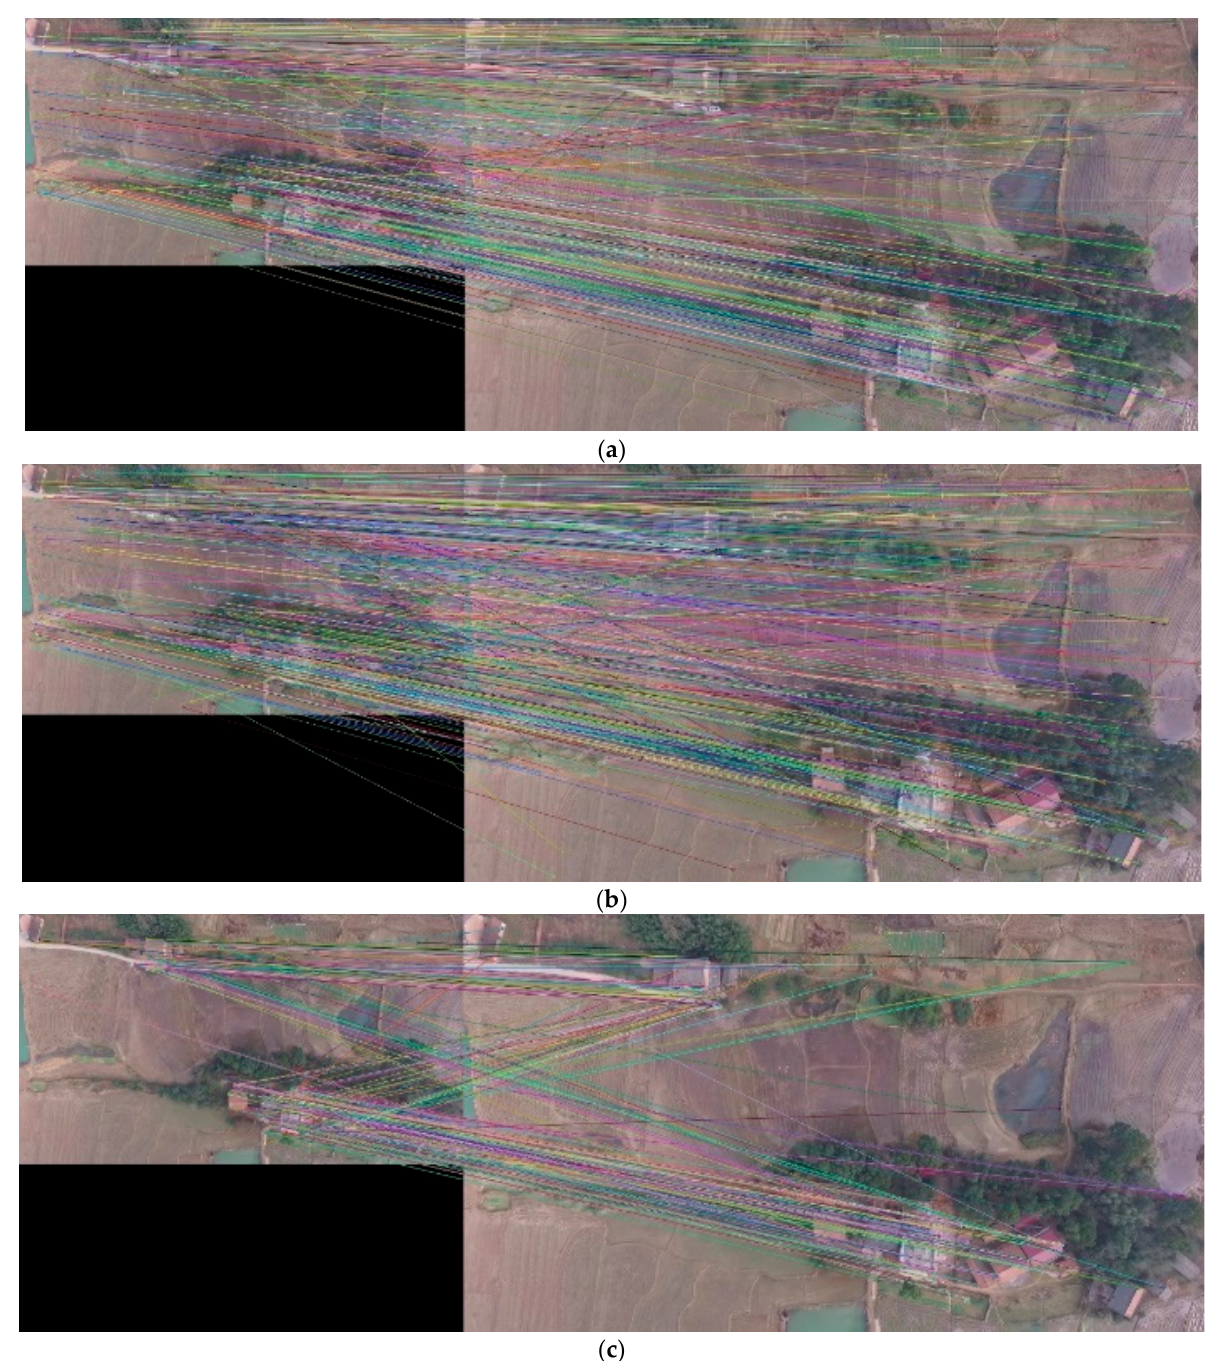
Figure 11. The matching of the original image with its scaled image using: ( a ) SIFT feature extraction